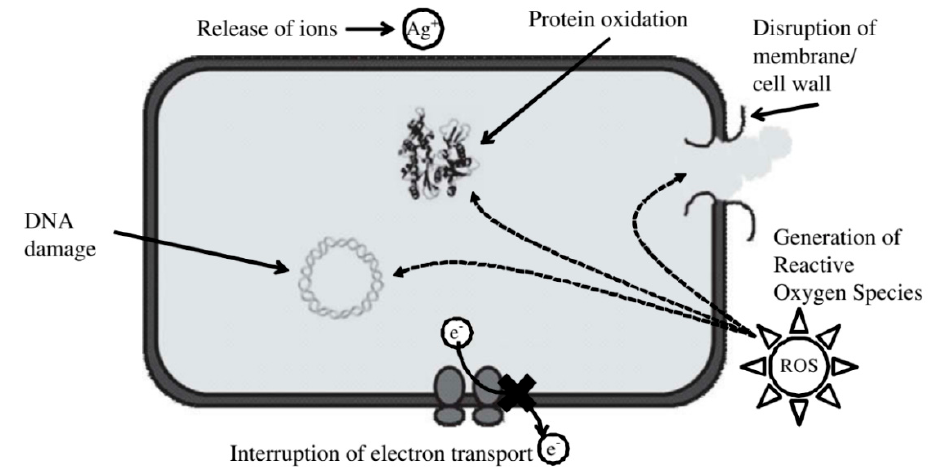
Figure 5. Schematic presentation of the different mechanisms of antimicrobial action of nanomaterials (Reproduced with permission from [161]).